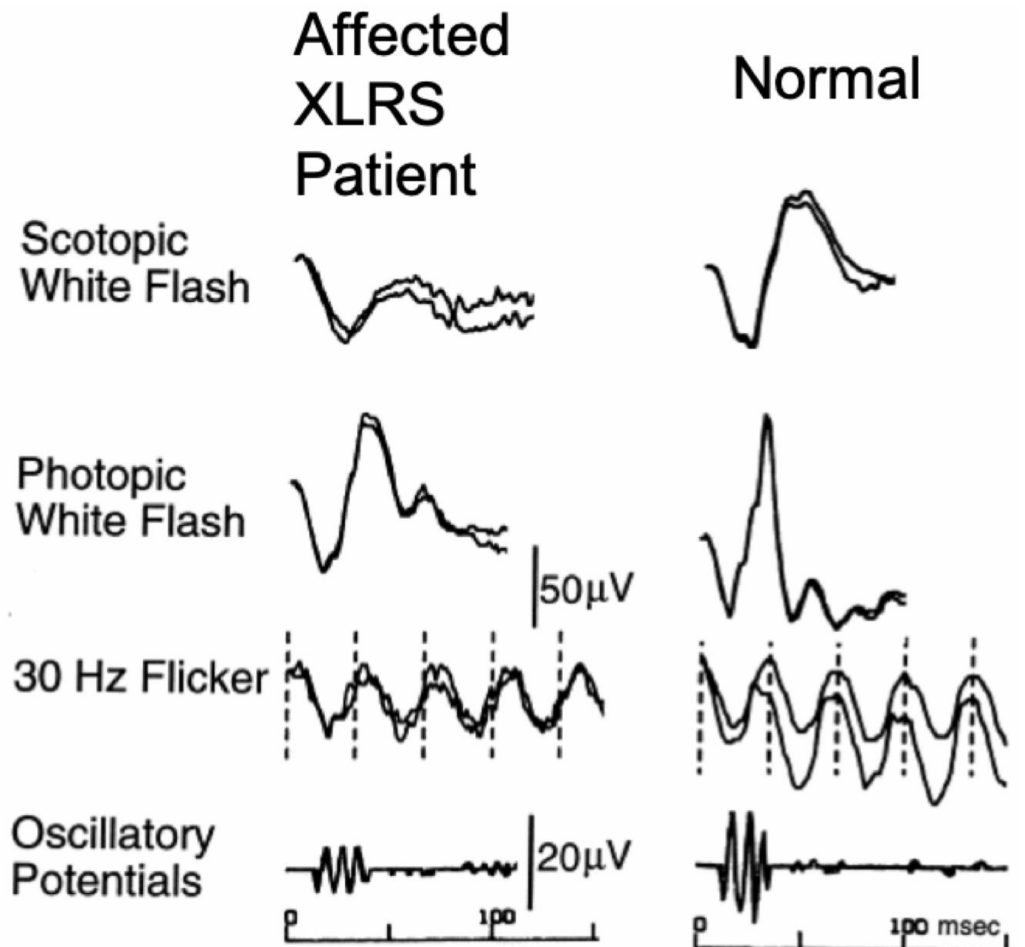
Figure 3. Electronegative response to white flash stimulation under scotopic condition in a XLRS patient (adapted from Sieving 1999 with permission